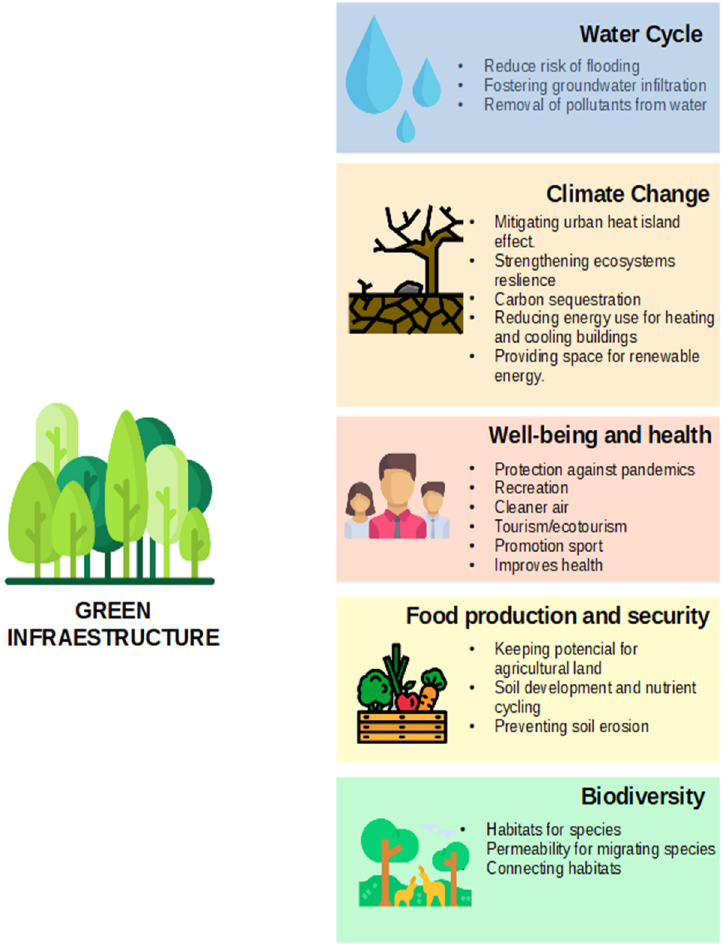
Figure 1. A Potential Ecosystem of Green Infrastructure Services.